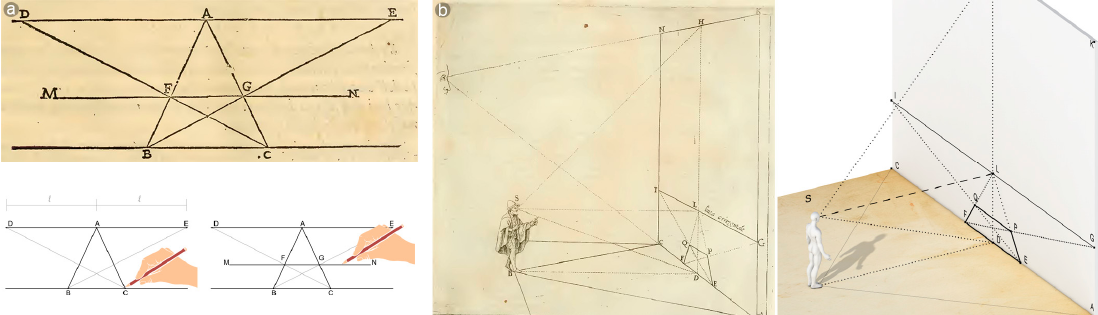
Figure 2. ( a ) Illustration of the first theorem, first proposition, contained in the introductory part of the Treaty. The theorem deals with a plan geometry problem—regarding the parallelism between lines—that does not yet refer explicitly to prospective constructions, but is preparatory to it; ( b ) Illustration of the prospective construction of a square that implies the properties exhibited in the first